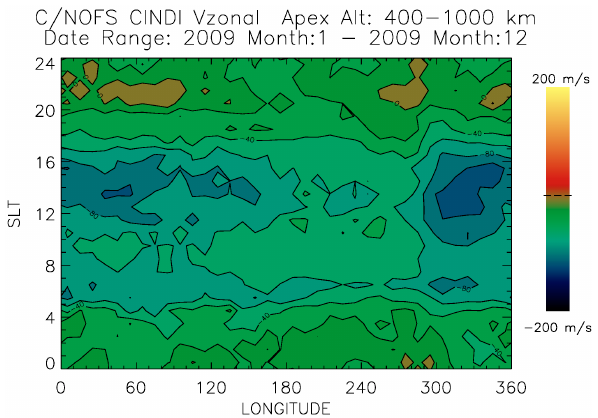
450 Figure 6. Contour plot of CINDI zonal velocities versus SLT (hours) and longitude 451 for the year 2009. All available data in the 400–1000 km apex altitude range was 452 Fig. 6. Contour plot of CINDI zonal velocities versus SLT (hours) used. 453 and longitude for the year 2009. All available data in the 400– 454 1000km apex altitude range were used.